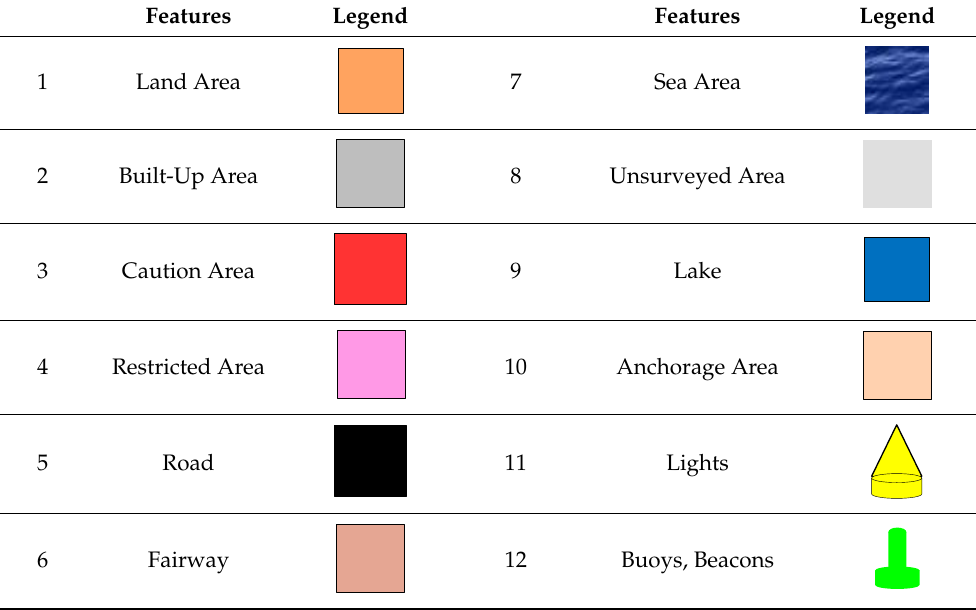
Figure 12. The construction time and query time of three spatial index structures. ( a ) The construction time of three spatial index structure; ( b ) The query time of three spatial index structure.